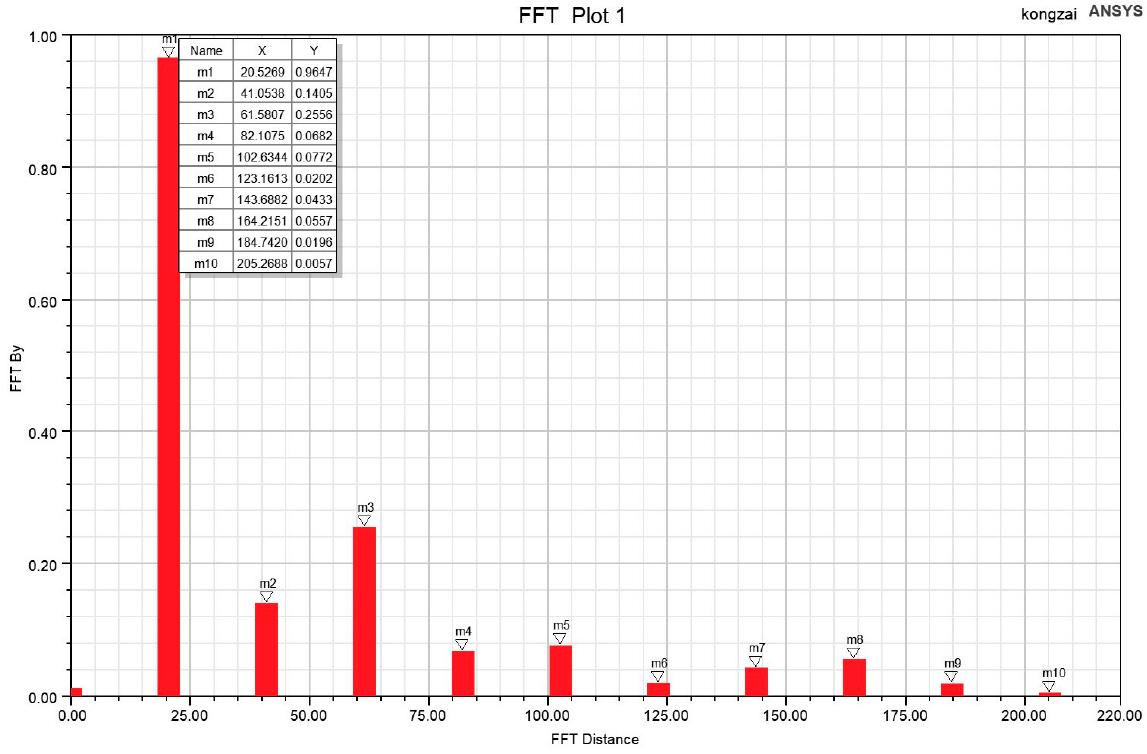
Figure 10. Air gap magnetic density Fourier analysis.